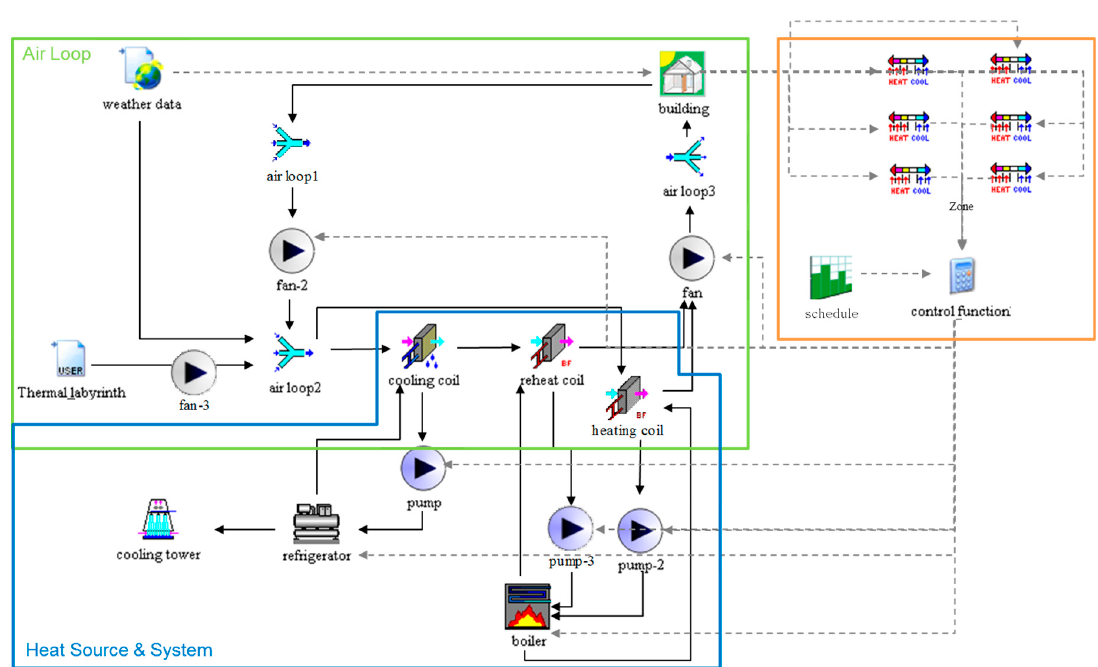
Figure 14. TRNSYS modeling of the system with the building.